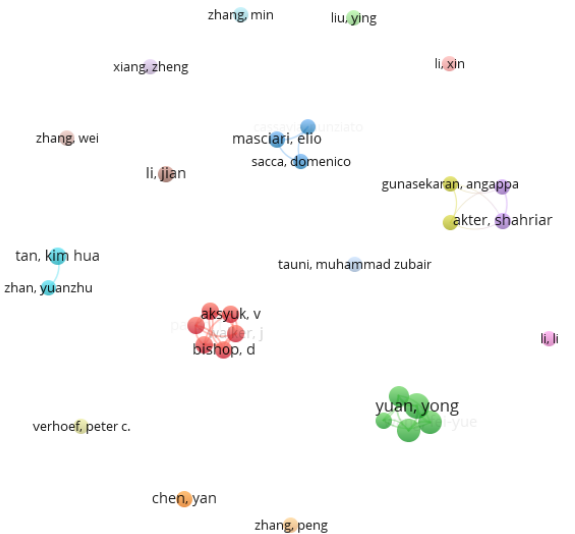
Figure 3. Co ‐ authorship network by authors. Figure 3. Co-authorship network by authors.